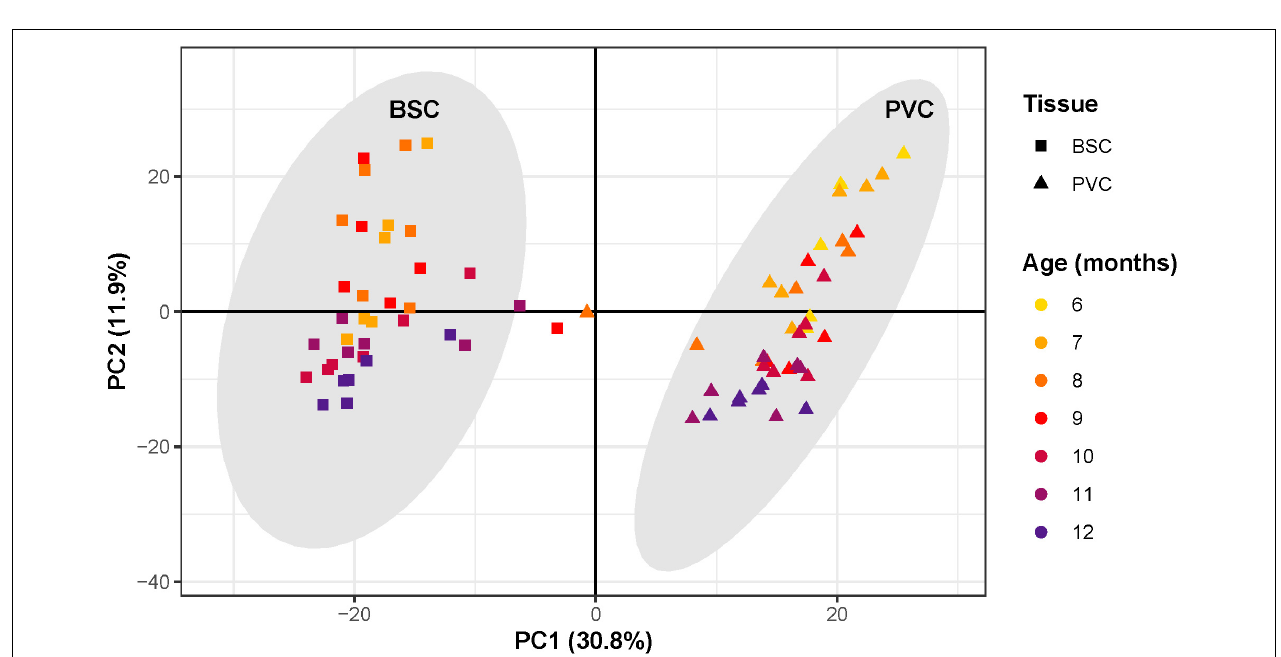
FIGURE 2 | Cohort reflex behavior performance with age. The stages of aging behavior range defined by Kempsell and Fieber (2014) are represented as gray boxes in the plot space and labeled at the bottom of the plot. Boxes labeled with different letters are considered significantly different by pairwise Wilcoxon test (fdr-corrected p ≤ 0.05). (A) Boxplot of righting reflex behavior performance at each month of randomly selected animals. (B) Tail withdrawal reflex behavior performance at each month of randomly selected animals.